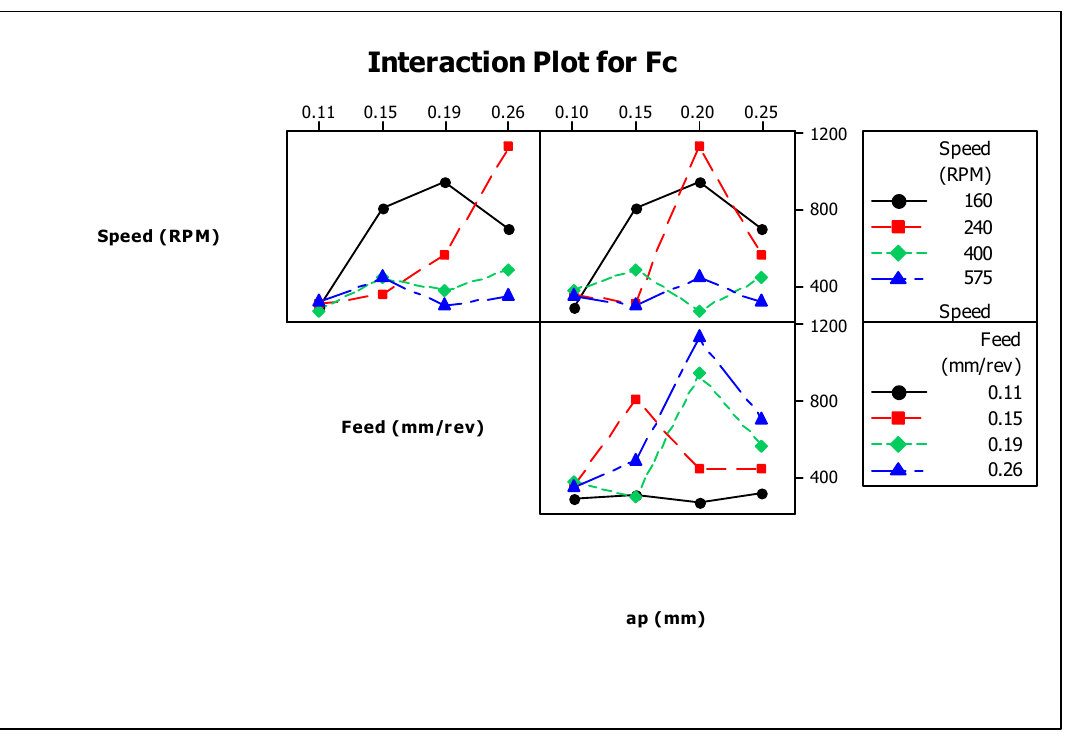
Figure 6. Interaction plot for cutting force (FC).